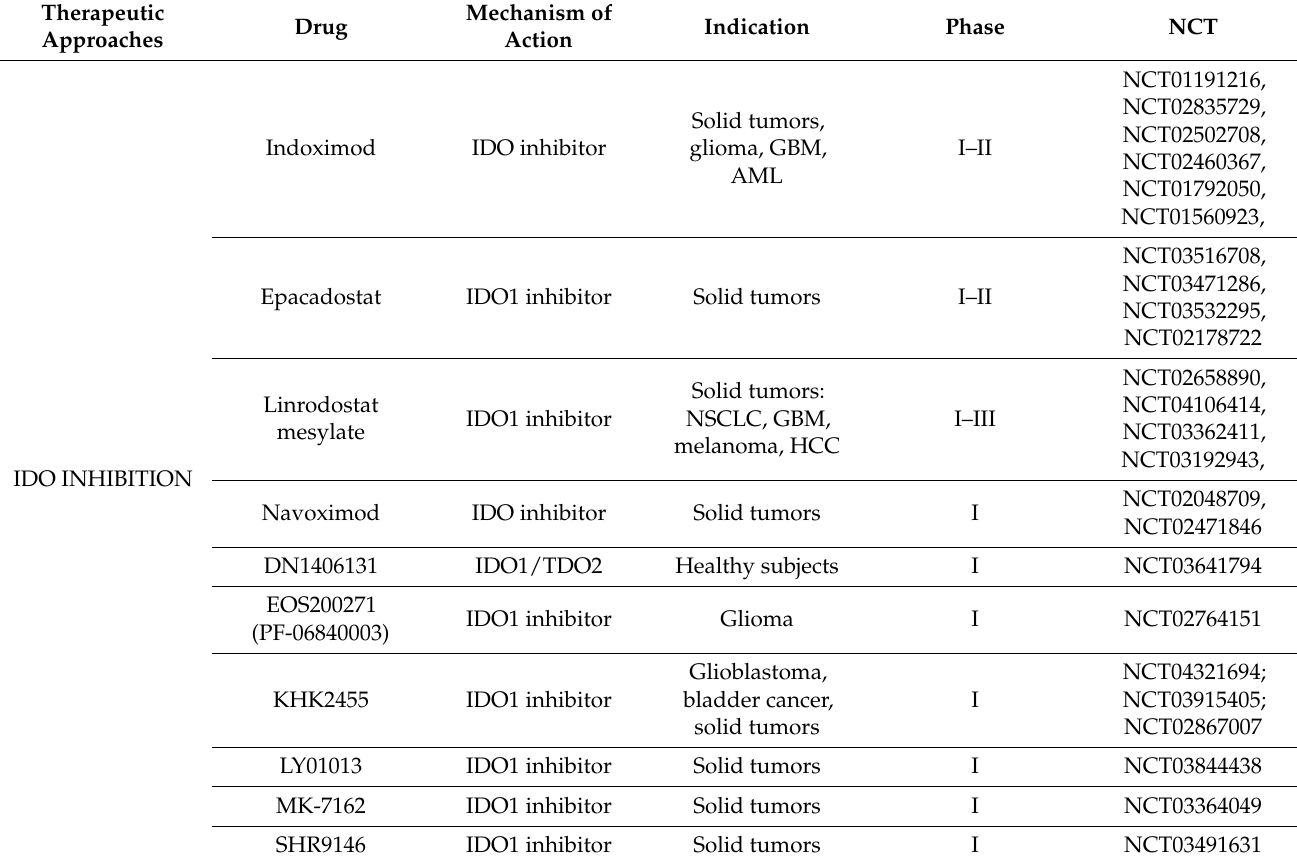
Table 1. Therapeutic approaches targeting tumor microenvironment metabolism and examples of clinical trials evaluating the safety and efficacy of these molecules. GBM, glioblastoma multiforme; AML; acute myeloid leukemia; NSCLC, non-small cell lung cancer; HCC, hepatocellular carcinoma; GI, gastrointestinal. Therapeutic Approaches